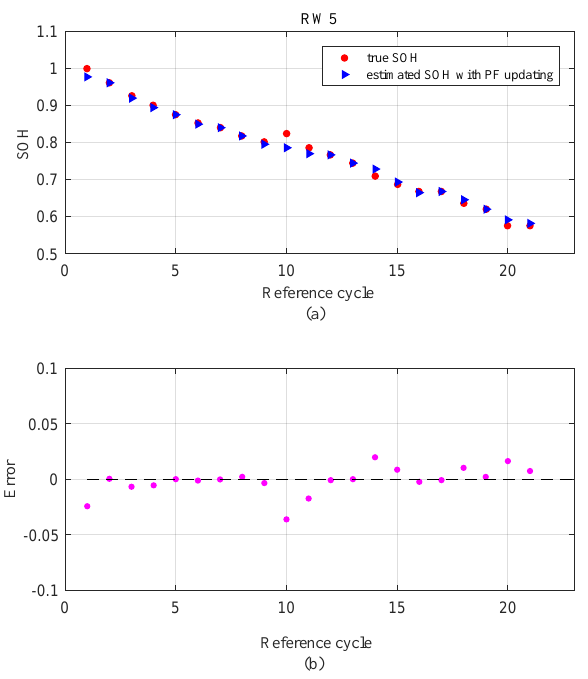
Figure 18. ( a ) SOH estimation results and ( b ) estimation errors for battery RW5 using indirect HIs with PF